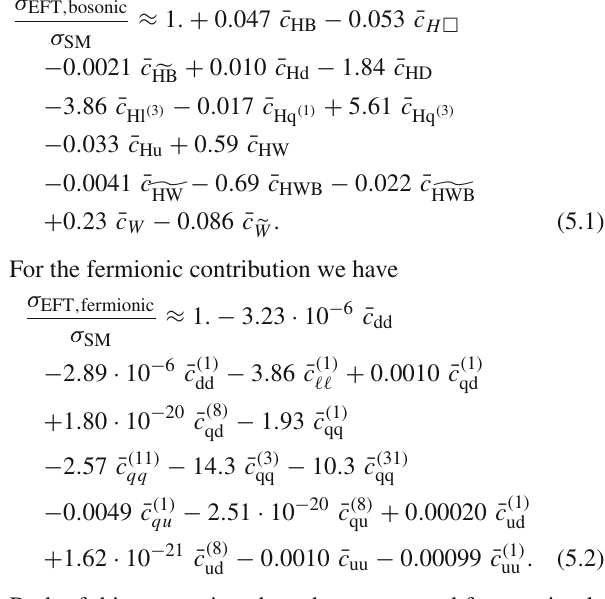
Fig. 3 Relative contribution given by each of the best-fit values. Oper- ators that enter the VBS(ZZ) cross section but have not been fitted in the past have been set to zero in these figures. On the left we use the values from the LEP fit, Ref. [118] and on the right from the LHC fit Ref. [122]